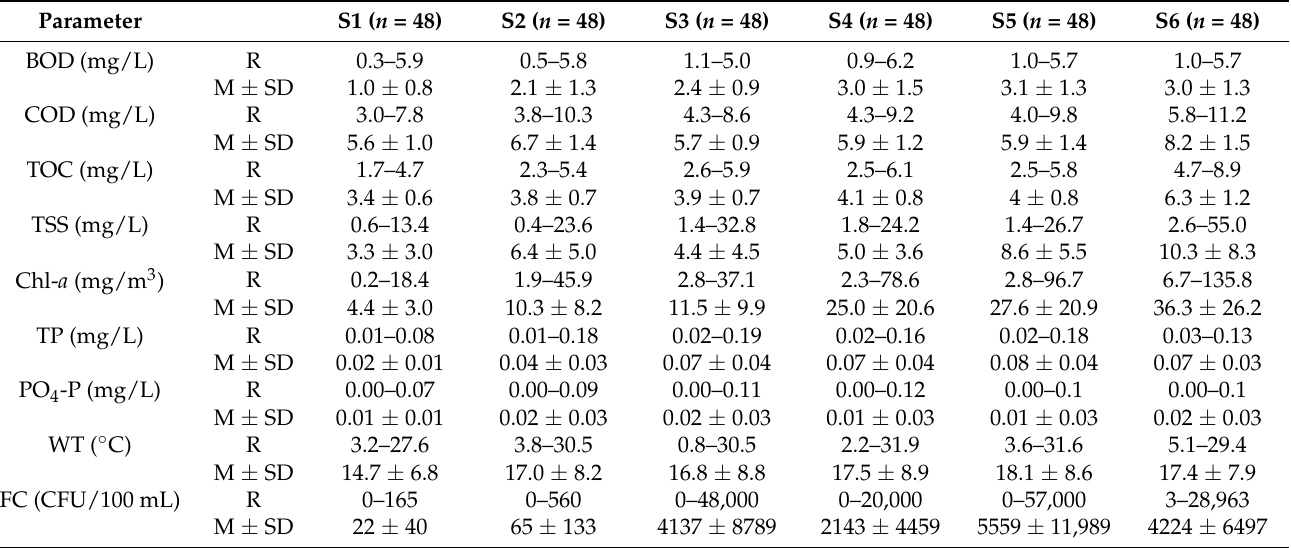
Table 3. Range, mean, and standard deviation for variables at the water quality monitoring